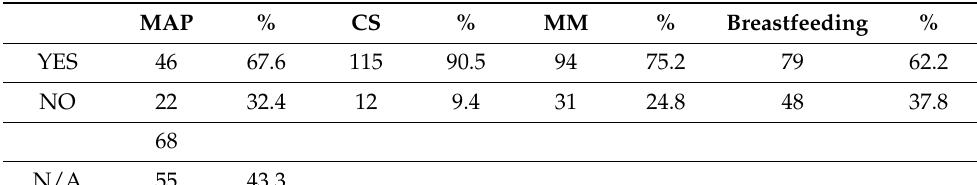
Table 4. MAP, CS, Feeding with MM, Breastfeeding.